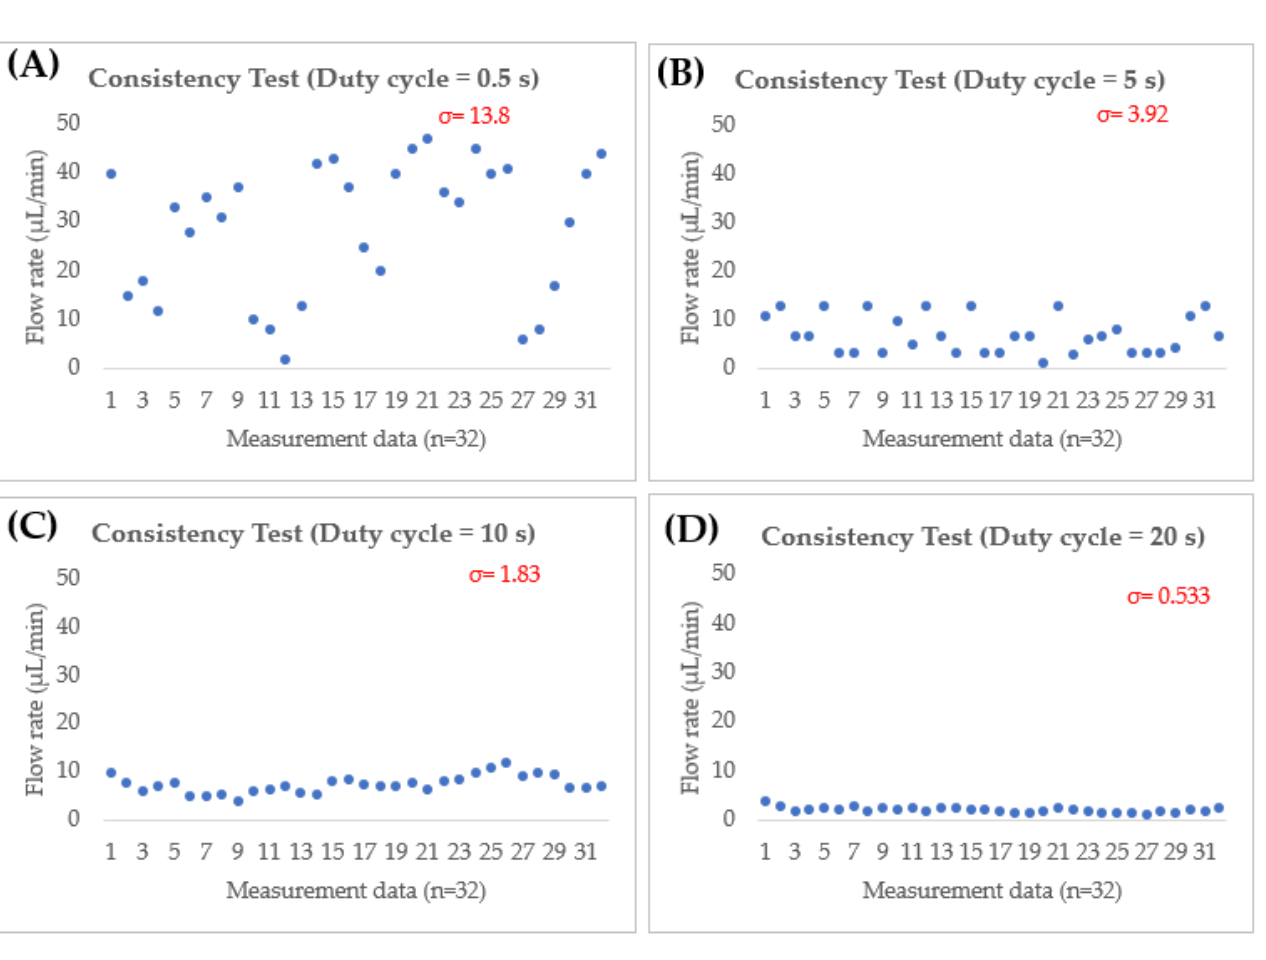
Figure 11. Flow rate for the operation of a fi nger actuated-based micro fl uidic system in ( A ) 0.5 s, ( B ) 5 s, ( C ) 10 s and ( D ) 20 s intervals.